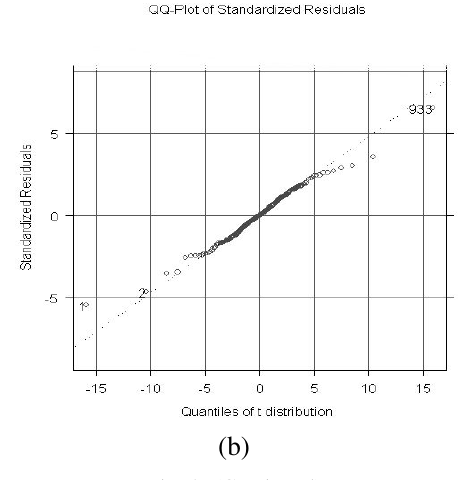
Fig. 3. QQ-plot of Gaussian standard residuals (a), studen- tised residuals (b) and generalised (GED) residuals